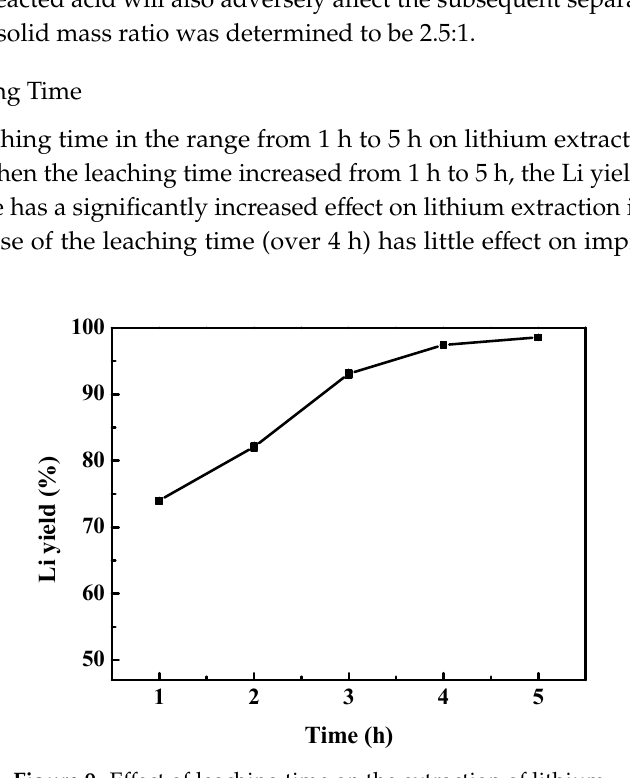
ff ect of leaching time on the extraction of Figure 9. Effect of leaching time on the extraction of lithium. Figure 9. E Figure 9. Effect of leaching time on the extraction of lithium.